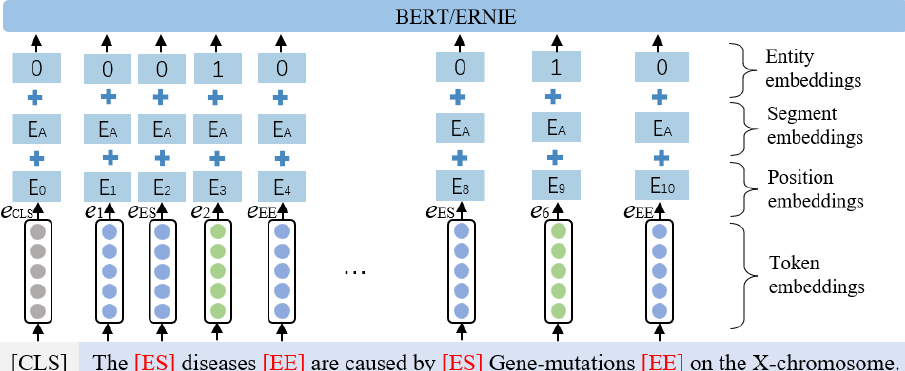
Figure 4. The entity-type embeddings are added to the input embeddings.